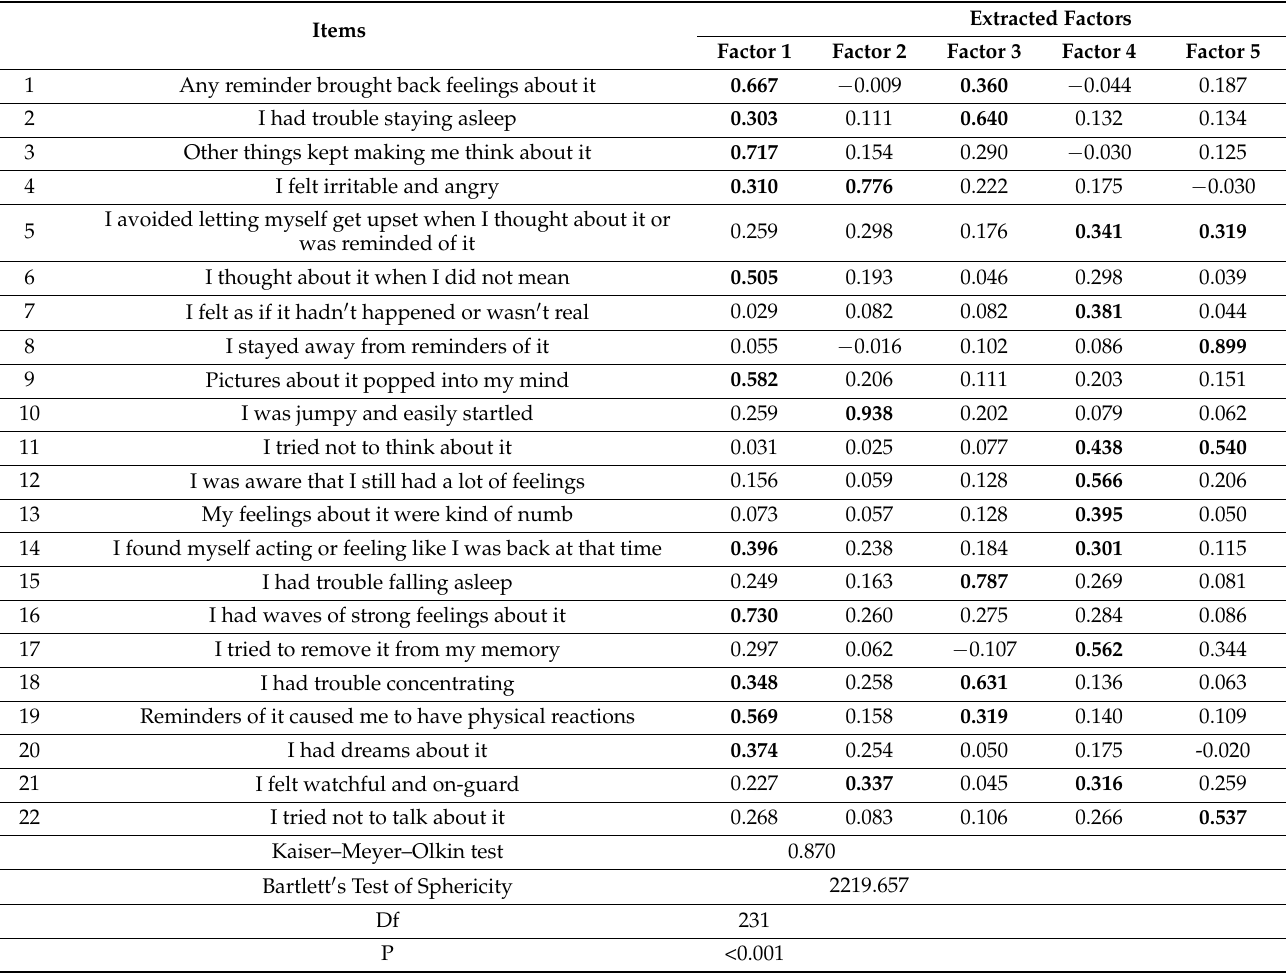
Table 2. Exploratory factor analysis of the Arabic version of the Impact of Event Scale-Revised (IES-R) in the quarantine